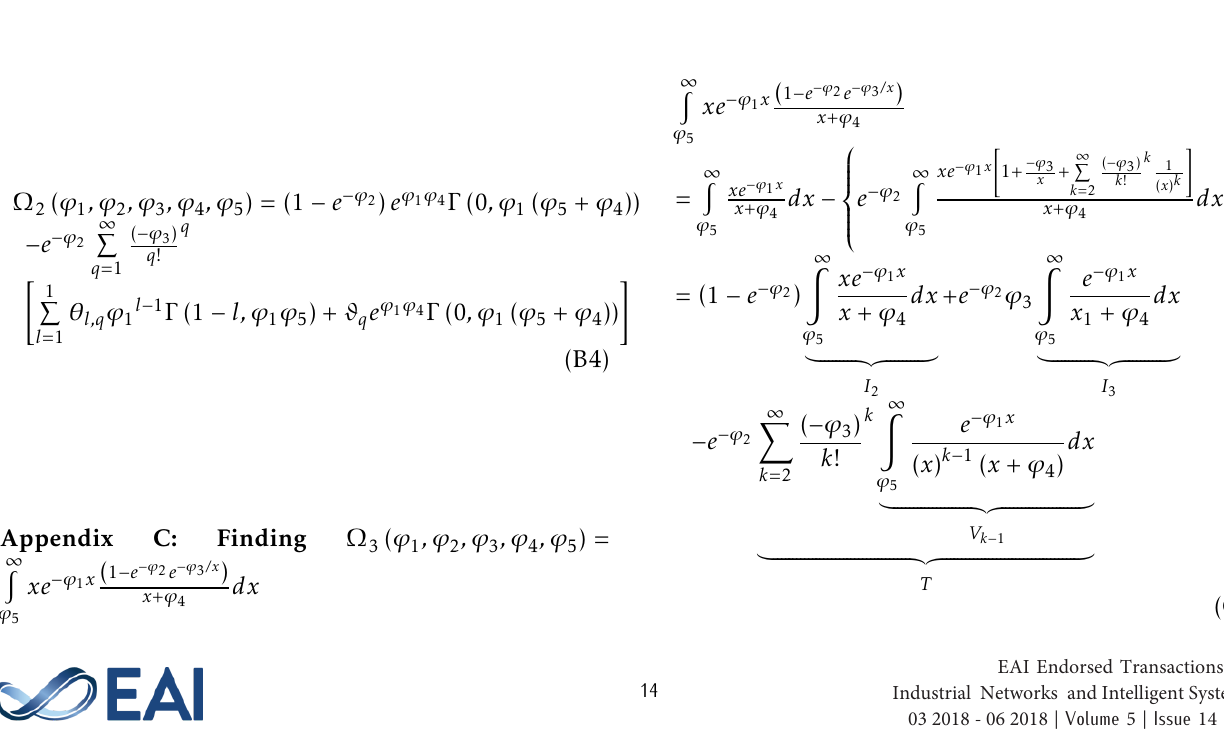
Figure 6. Outage probability versus η of the DR-BSR and NDR-BSR protocols and for ( M, N ) = (2 , 4) , and ( M, N ) = (4 , 2) with ( x R 1 , y R 1 ) = (0 . 5 , 0 . 3) , ( x R 2 , y R 2 ) = (0 . 5 , − 0 . 3) , P = 5 dB, ψ t = 1 bits/s/Hz, and ρ = 0 . 5 . Substituting (B2) and (B3) into (B1), we